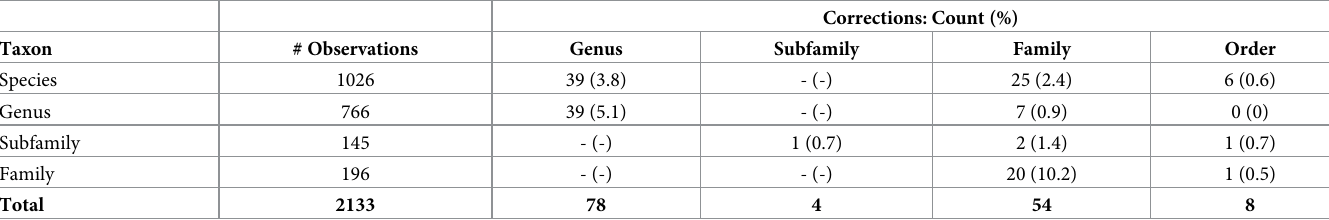
Table 3. Number of observations at different taxonomic levels and the number of corrections.